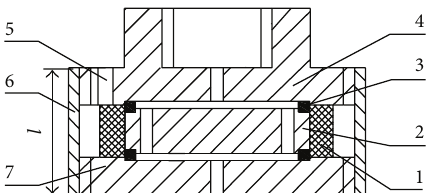
Figure 2: The electromagnetic piston with combined type: (1) coil, (2) middle magnetizer, (3) gasket, (4) upper magnetizer, (5) wire hole, (6) piston sleeve, and (7) under magnetizer.